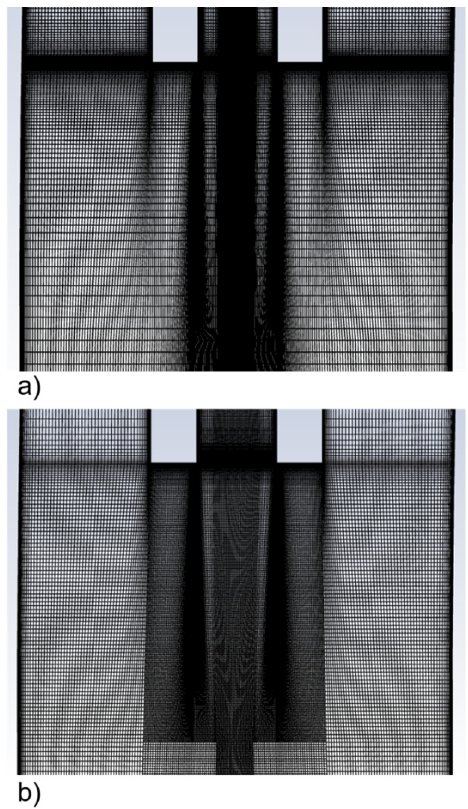
Figure 2. Comparison of the mesh for LES ( a ) and RANS ( b ) models in the x-y plane.